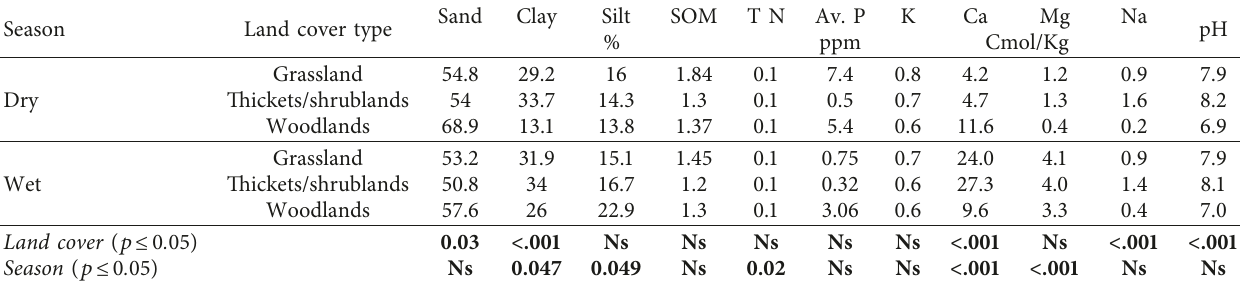
Land cover ( p ≤ 0 . 05) <.001